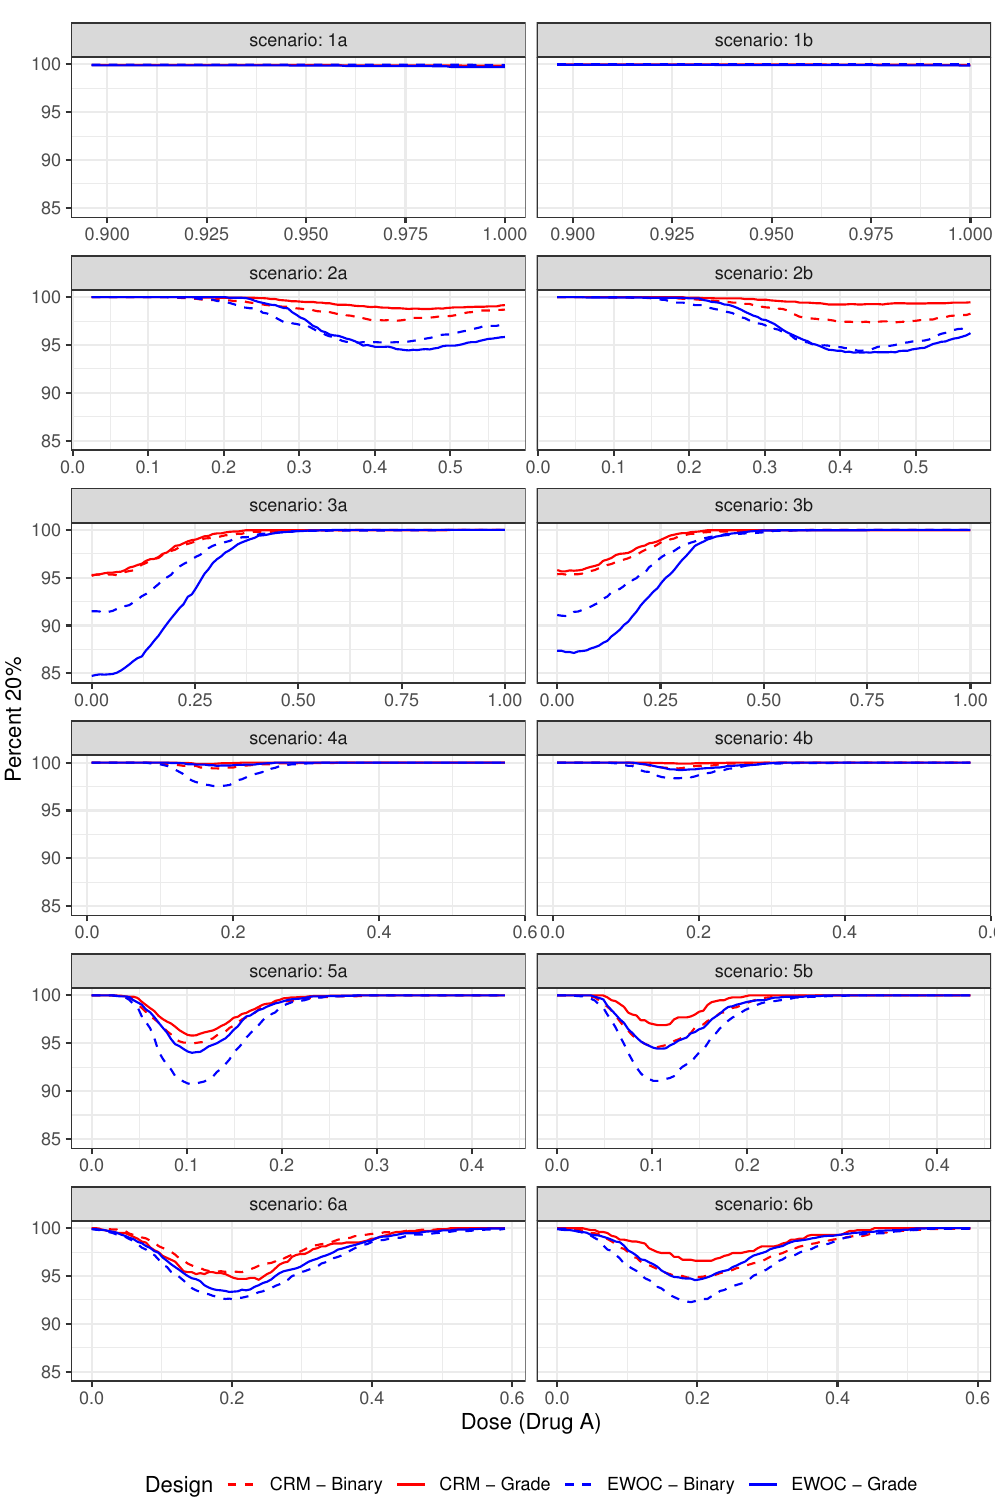
Figure 4. Pointwise percent of MTD recommendation for p = 0.2 under Scenarios